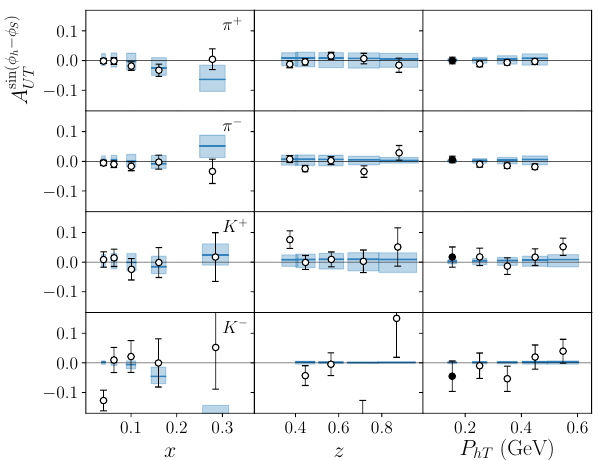
Figure 9. Description of COMPASS SIDIS data [36] for π ± and K ± , only data with δ < 0 . 5 are shown. Solid (open) symbols data used (not used) in the fit. Blue line is the CF and the blue box is 68%CI of the fit of the data and prediction for the data not used in the fit.